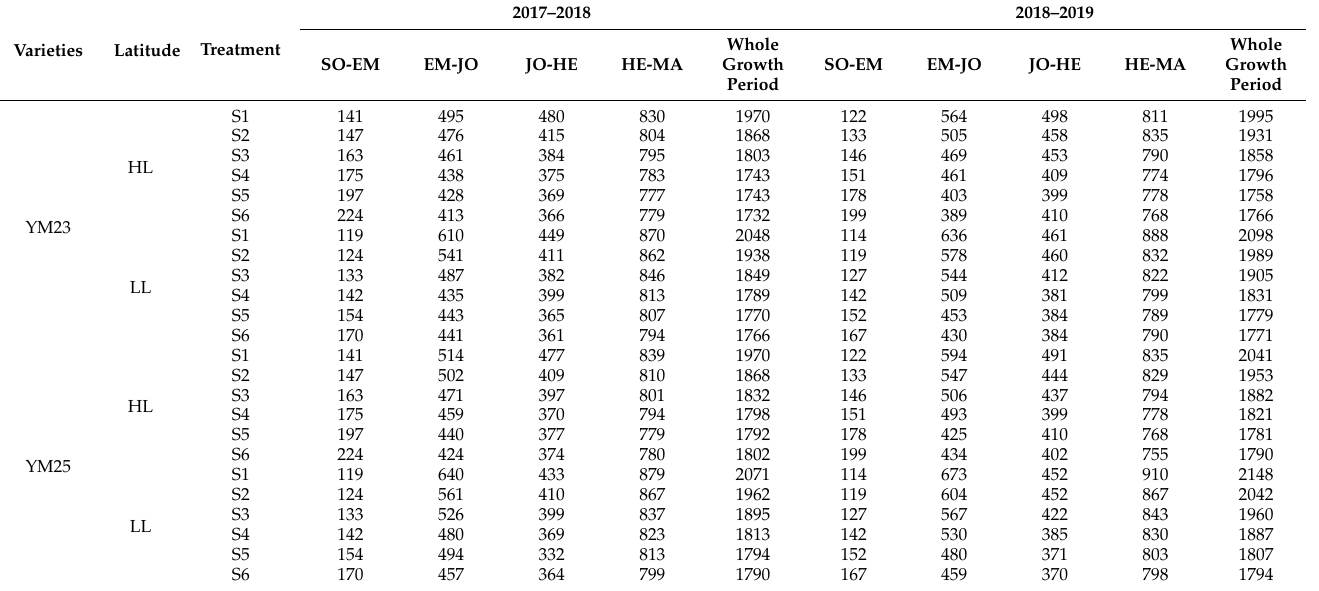
Table 1. Difference in the effective accumulative temperature at different latitudes and sowing dates ( ◦ C